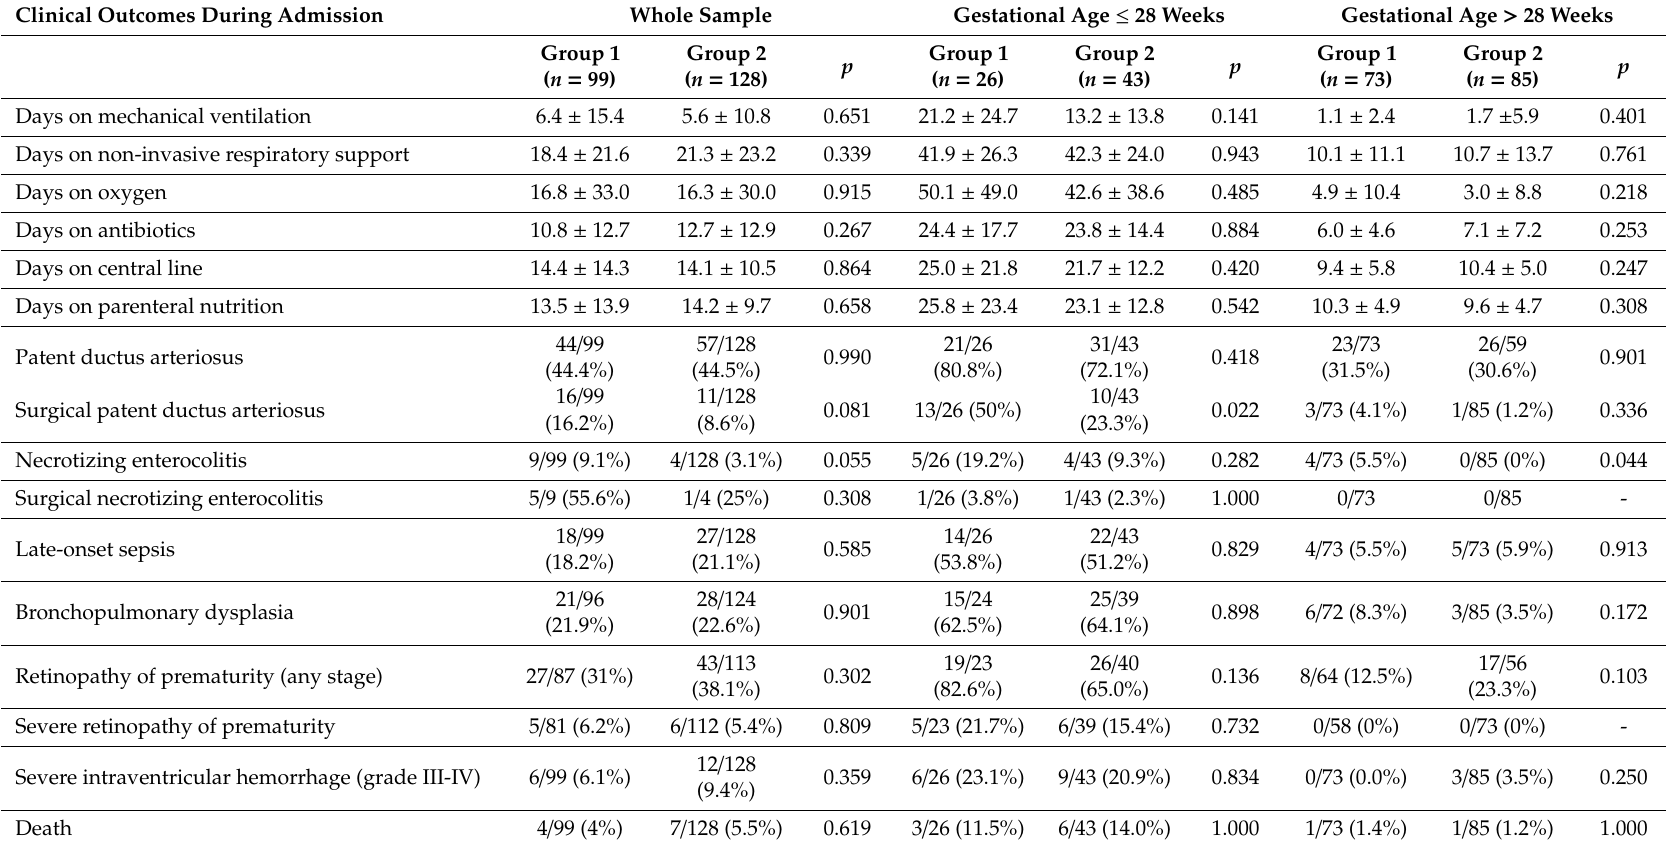
Table 3. Comparison of clinical outcomes between Group 1 and 2. Continuous variables are summarized as mean ± standard deviation and compared by Student’s t tests. Categorical variables are expressed as number and percentage and compared by chi-square tests or Fisher’s exact tests as